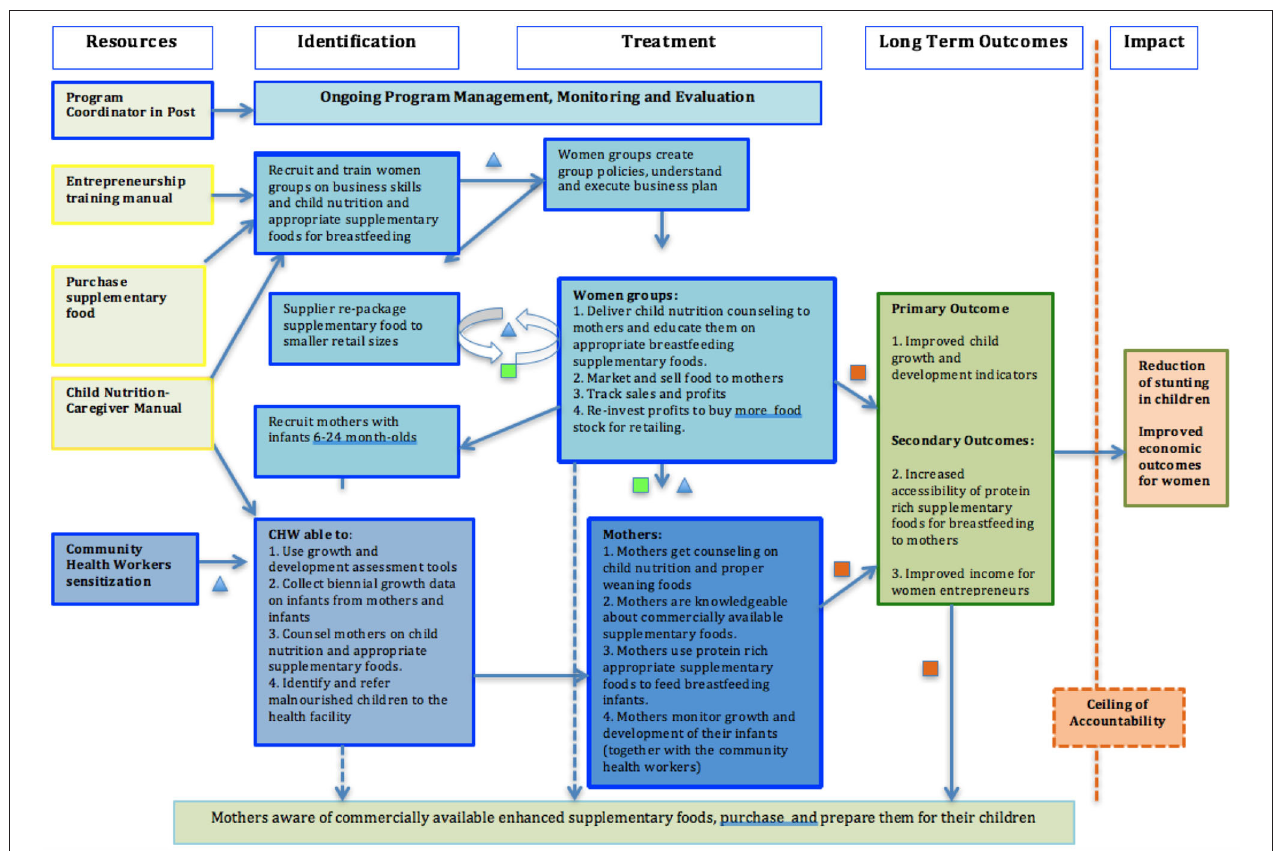
FIGURE 1 | Theory of